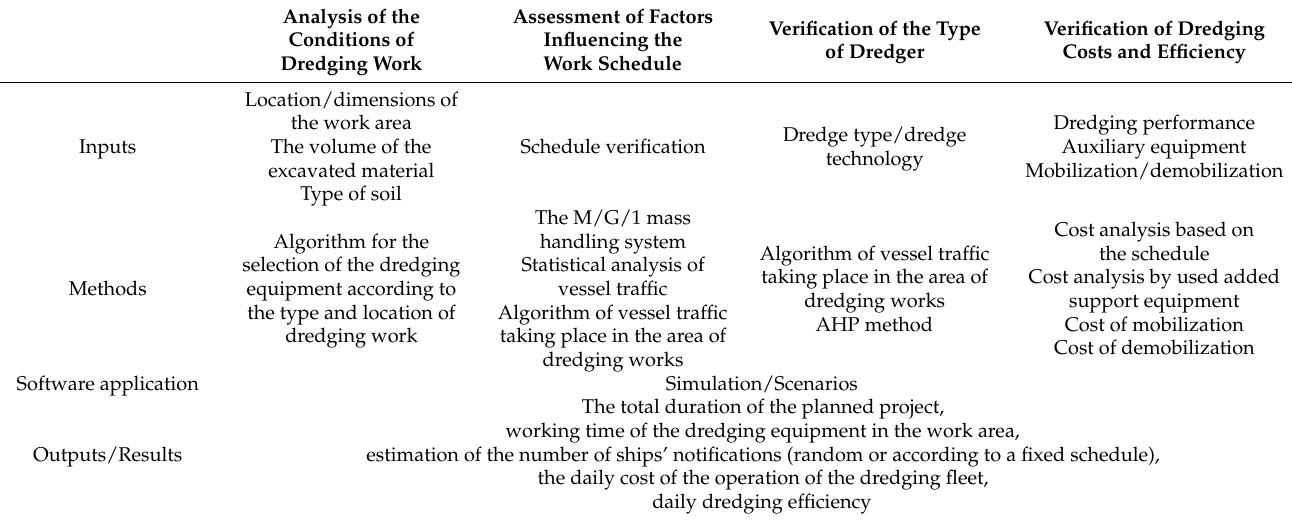
Table 1. The layout of all steps of the methodology and given results from inputs to outputs.